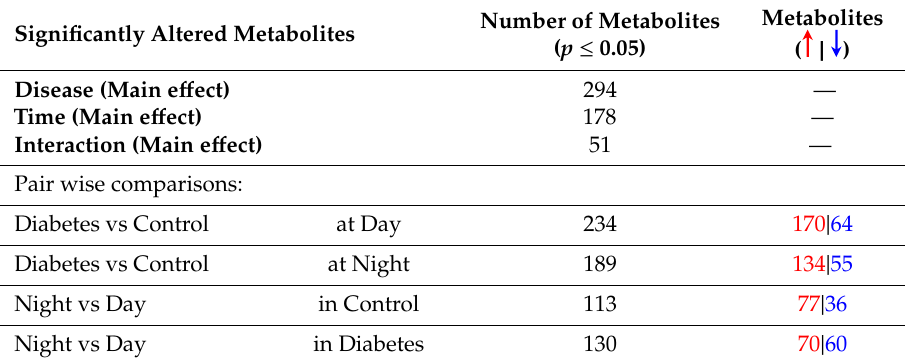
Table 1. Statistical summary of the analysis of total 747 detected metabolites by UPLC-MS.